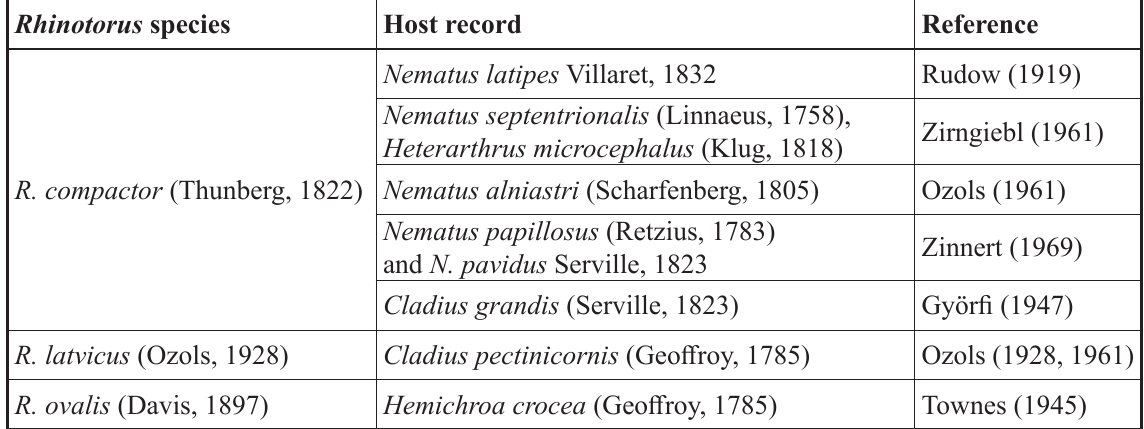
Table 1. Host records of Rhinotorus